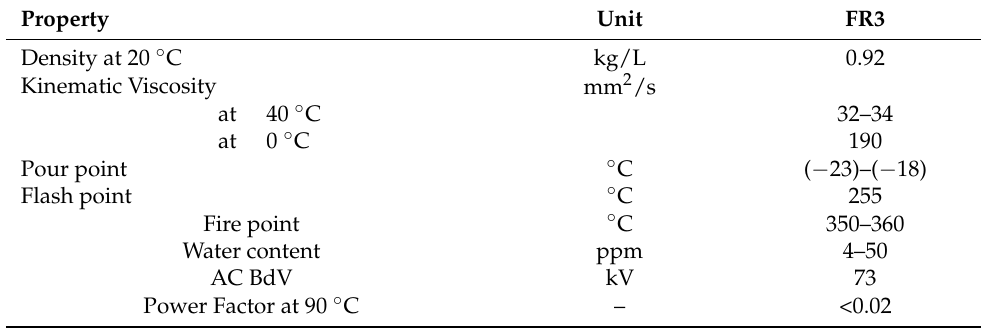
Table 1. Physicochemical properties of natural ester, FR3.